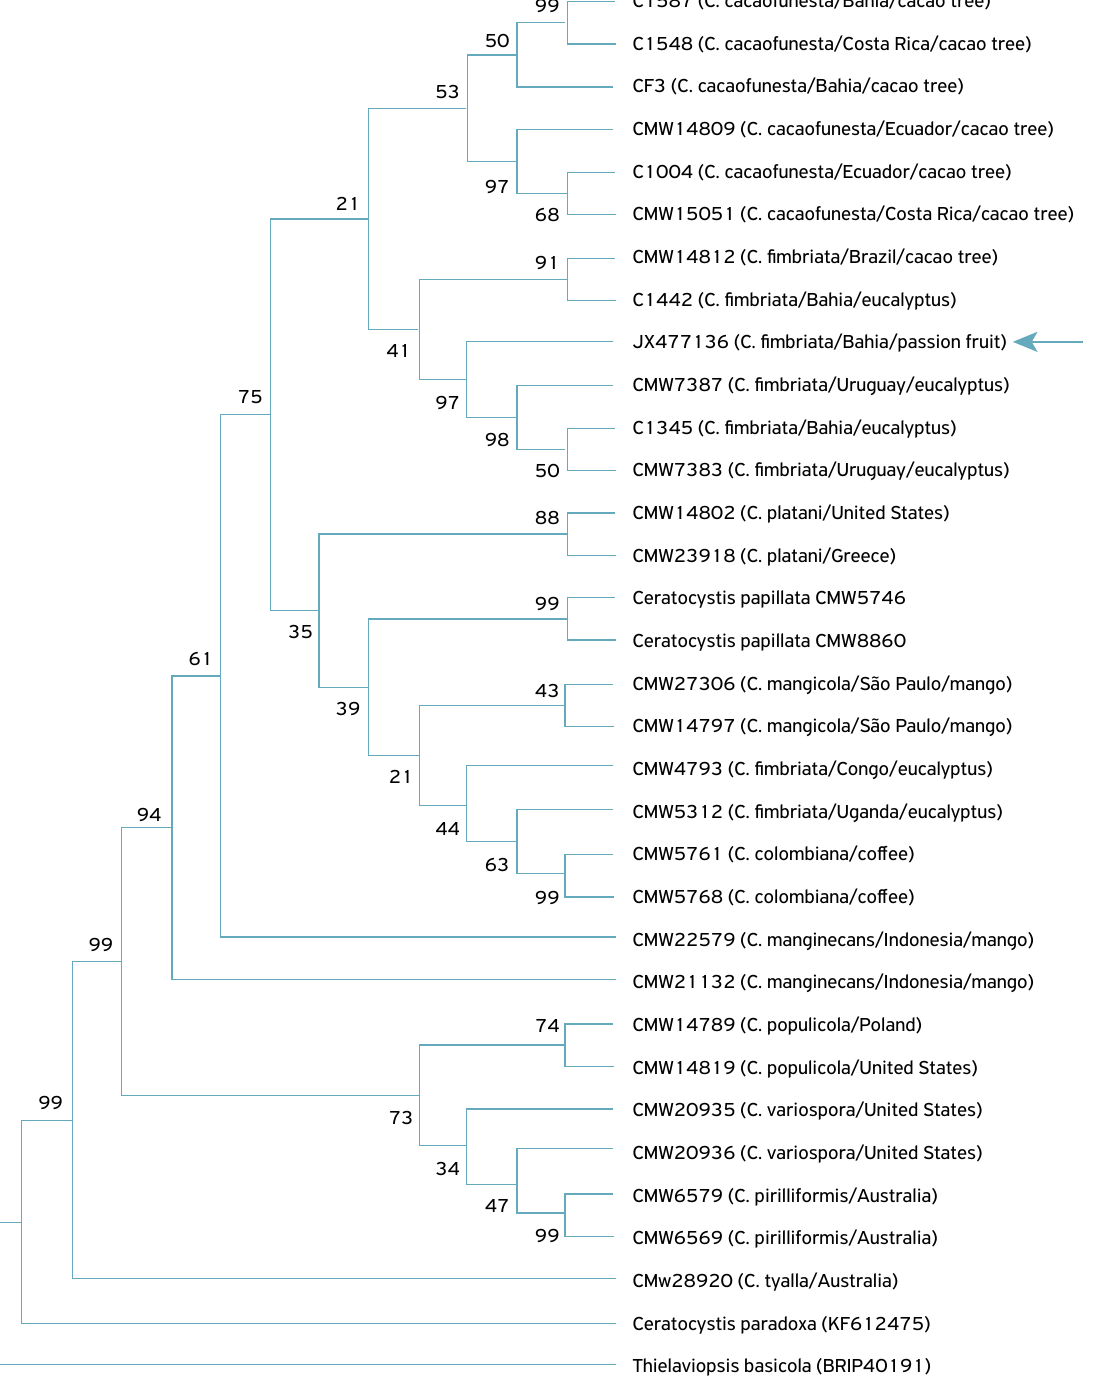
Figure 1. Phylogenetic tree, based on the ITS-5.8S region, of the Ceratocystis isolate collected from passionflower